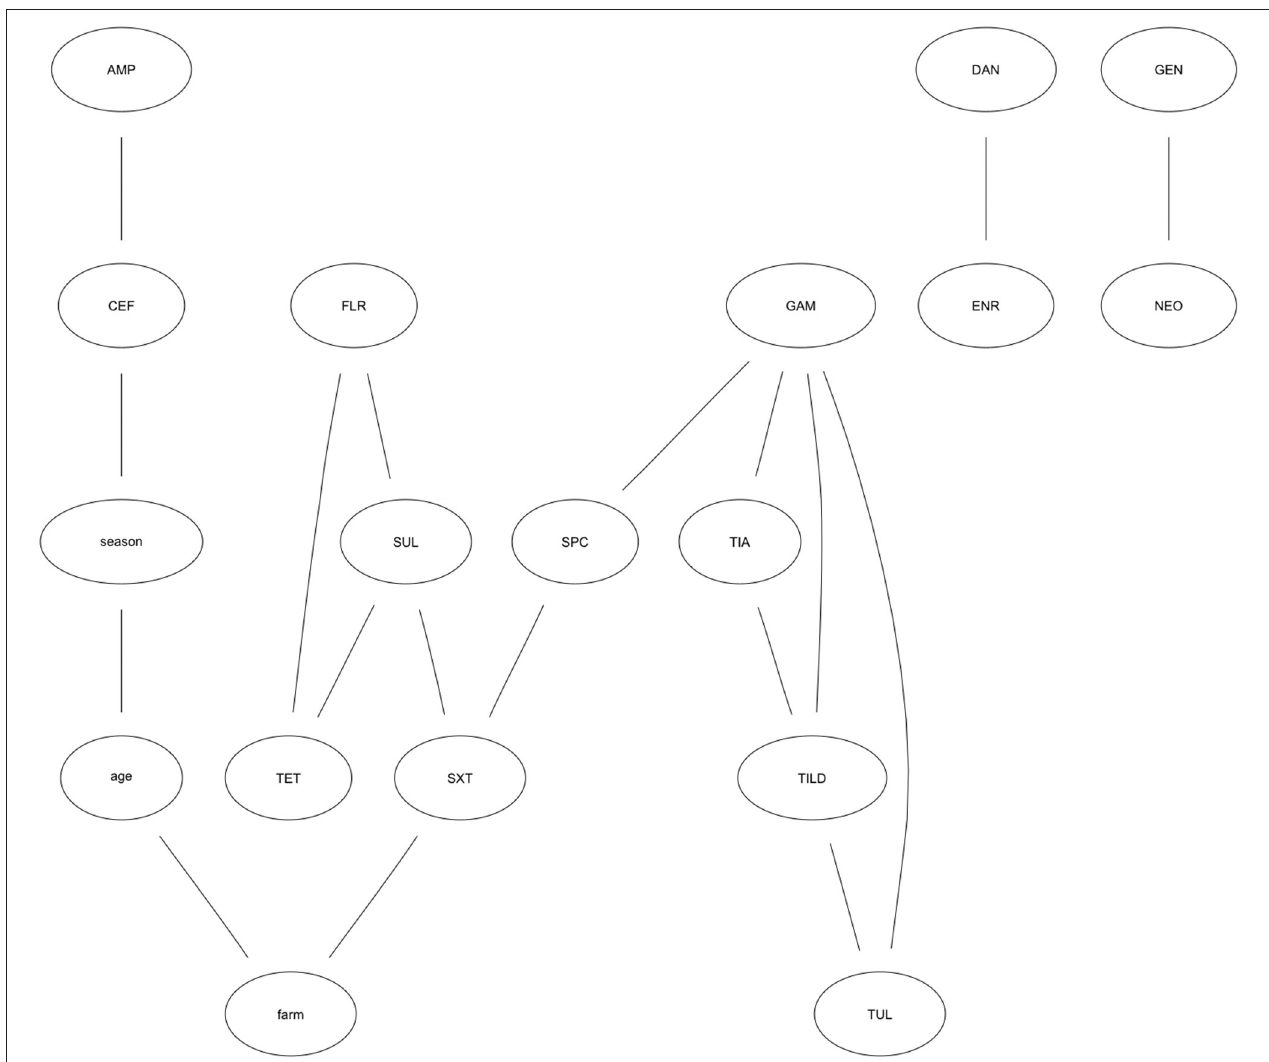
FIGURE 2 | Optimal Bayesian network model showing relationships among antibiotic MIC trends. Optimal Bayesian network modeling MIC patterns for Escherichia coli isolates collected from weaned heifers across five farms in California against 15 antibiotics. Antibiotics represented in each node include: CEF, Ceftiofur;